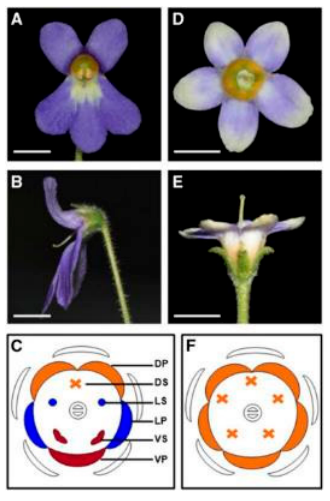
Figure 7. Front and side view and floral diagram of normal and peloric flowers of Petrocosmea sinensis [54]. ( A – C ) Front and side view and floral diagram of P. sinensis normal flowers, which have a typical bilaterally symmetrical corolla. ( D – F ) Front and side view and floral diagram of P. sinensis peloric flowers, which have a radially symmetrical corolla. DP, dorsal corolla lobes; DS, dorsal stamens; LS, lateral stamens; LP, lateral corolla lobes; VS, ventral stamens; VP, ventral corolla lobe. Reprinted with permission from Ref. [54]. Copyright © 2023, Oxford University Press.